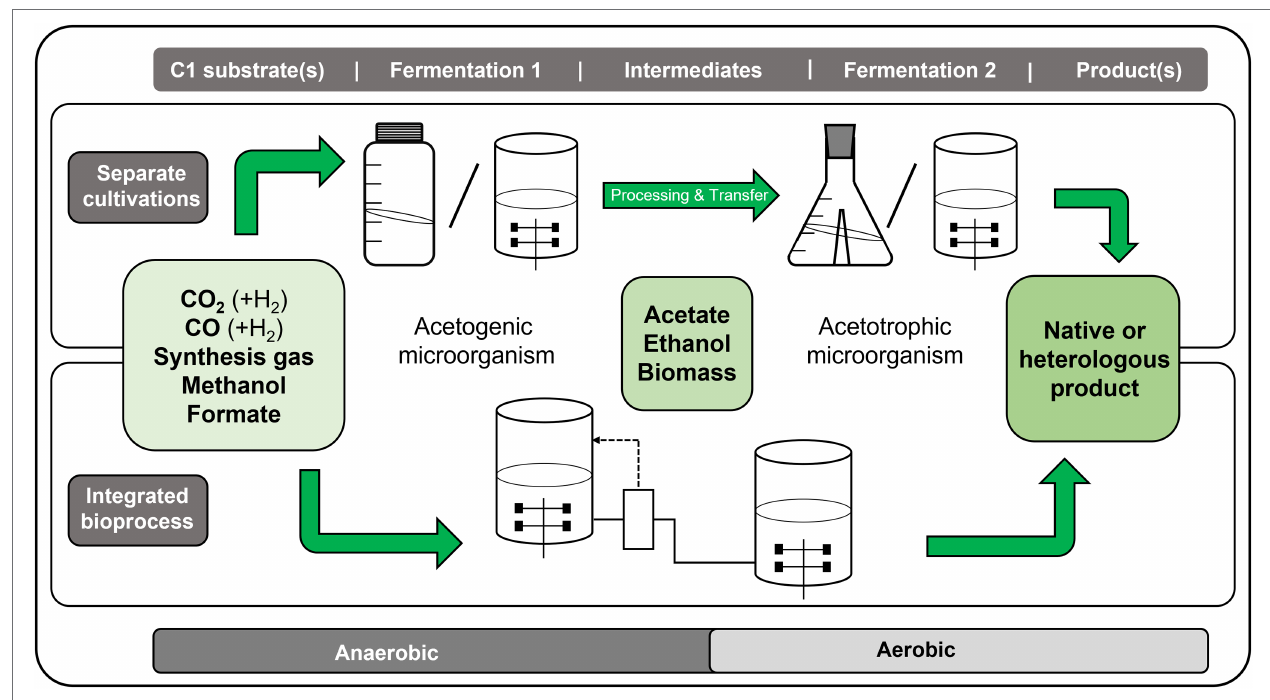
FIGURE 1 | Schematic overview of the concept of sequential C1 fermentations for the conversion of C1 substrates, such as gaseous CO 2 , CO, mixtures like synthesis gas (syngas), or liquids like methanol or formate, toward higher products via a two-step fermentation process. In the first fermentation process, the respective C1 substrate is converted anaerobically by an acetogenic microorganism into acetate and/or ethanol. This/these intermediate product/s is/are further converted in a second, aerobic fermentation by an acetotrophic/ethanotrophic microorganism into the desired end-product, which can be a native or a heterologous product of interest. The synthesis of higher-value products from C1 substrates with sequential C1 fermentations can either be achieved with a process that separates both steps (upper part) or by combining both steps in an integrated process (lower